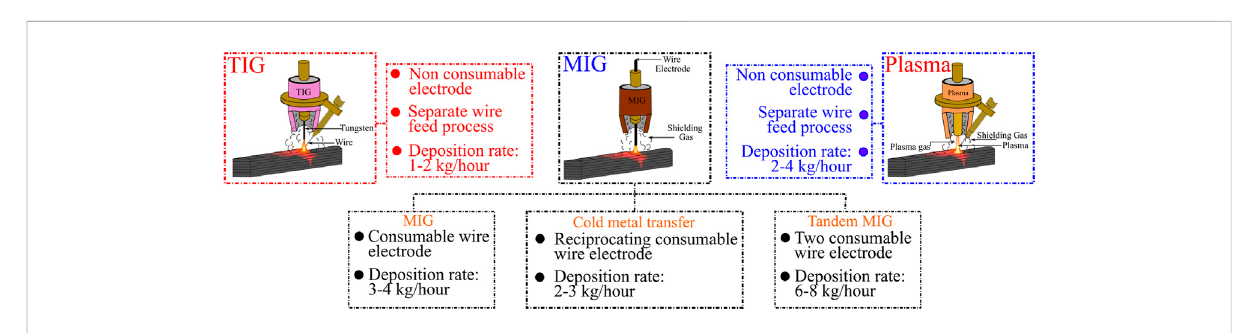
FIGURE 3 Classi fi cation based on different heat sources utilized in WAAM.